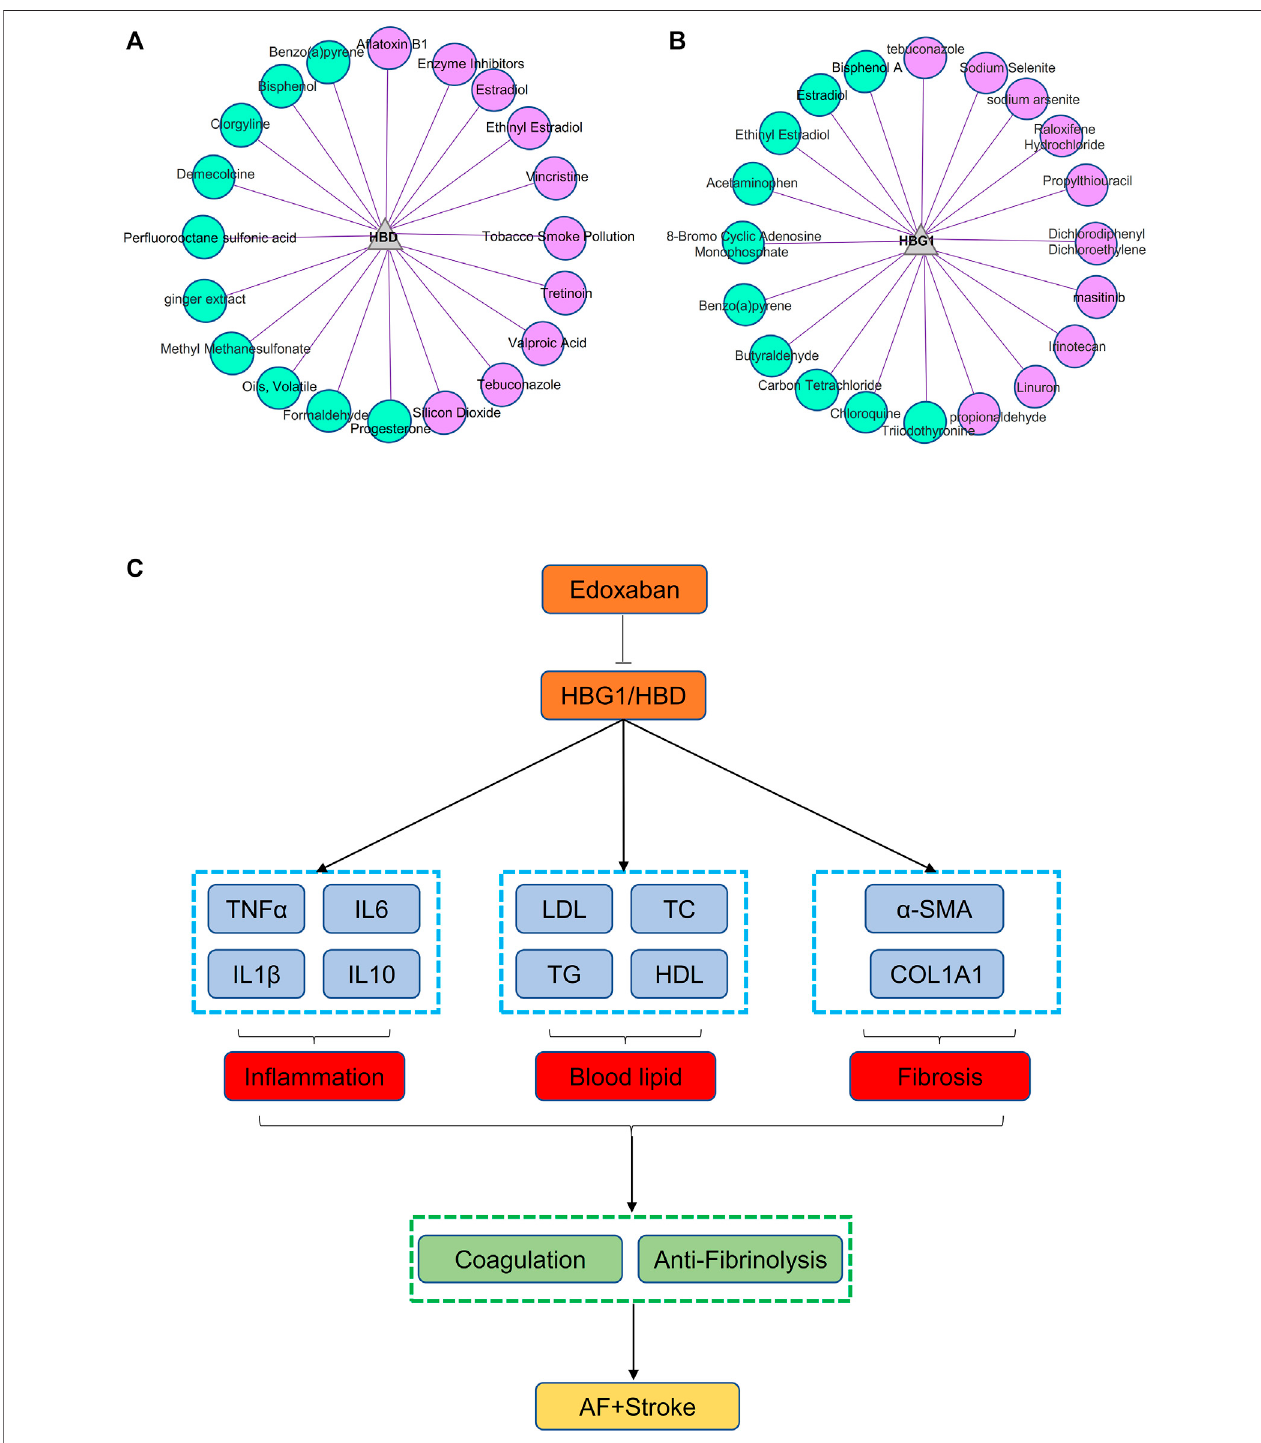
FIGURE 13 | Small molecule compounds related to HBG1 and HBD and the general idea diagram of the effect of edoxaban on the AF. (A) Small molecule compounds related to HBD. (B) Smallmolecule compounds related to HBG1. (C) General idea diagram ofthe effectof edoxaban on the AF. Edoxaban might inhibit the expressions of HBG1 and HBD and then inhibit in fl ammation, blood lipids, and fi brosis further. Furthermore, coagulation was inhibited, and fi brinolysis was activated at the effect of edoxaban. Finally, the development of AF to the stroke was prevented.